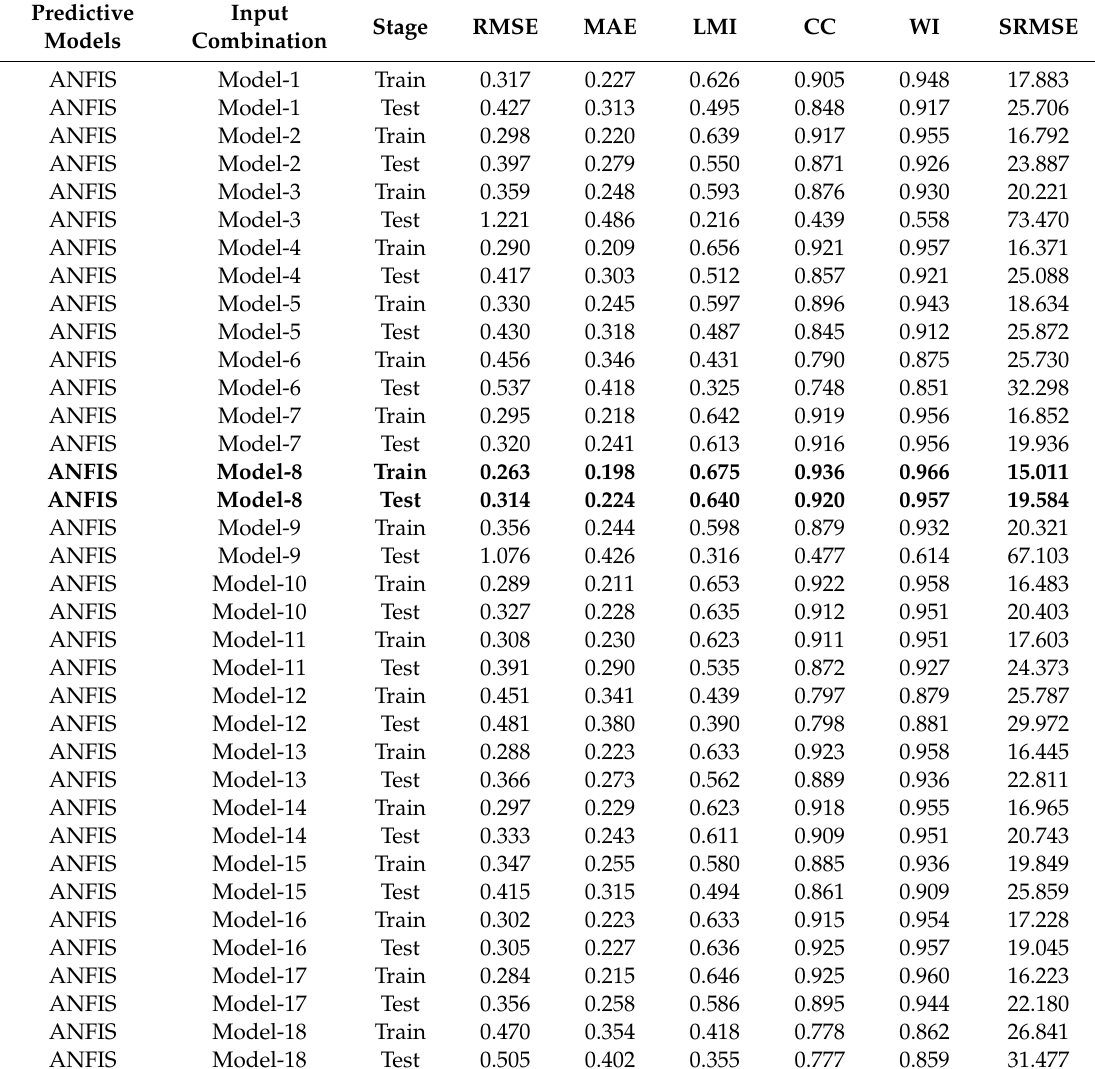
Table2. ThepredictionperformanceofthestandaloneANFISmodelforallproposedinputcombinations over the training and testing stage. The boldfaced represents the best ANFIS